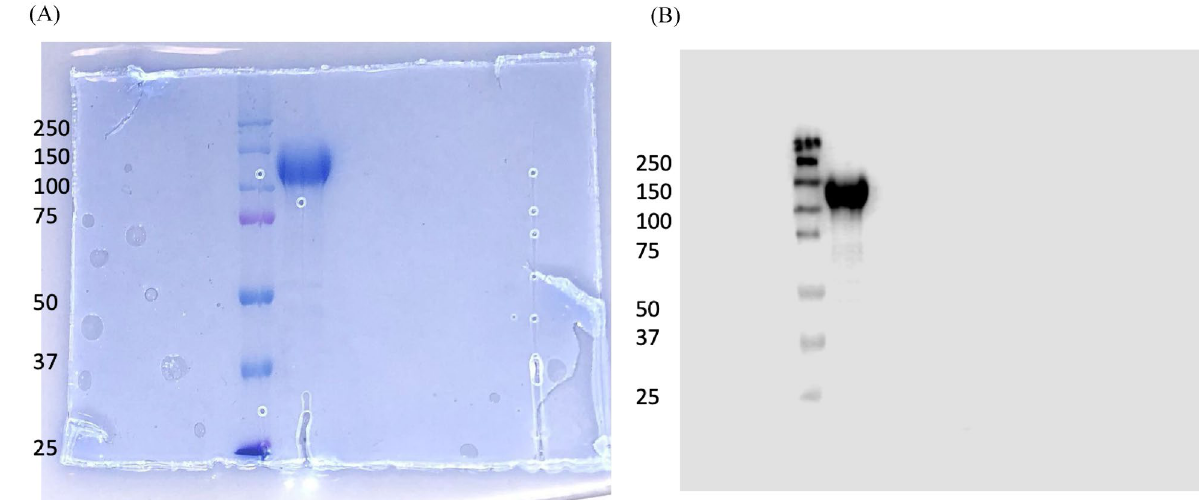
Figure 2. Analysis of the spike protein by Coomassie blue staining ( A ) and Western blot ( B ). Coomassie blue staining and Western blot of the gel confirmed the presence as well the integrity of the spike